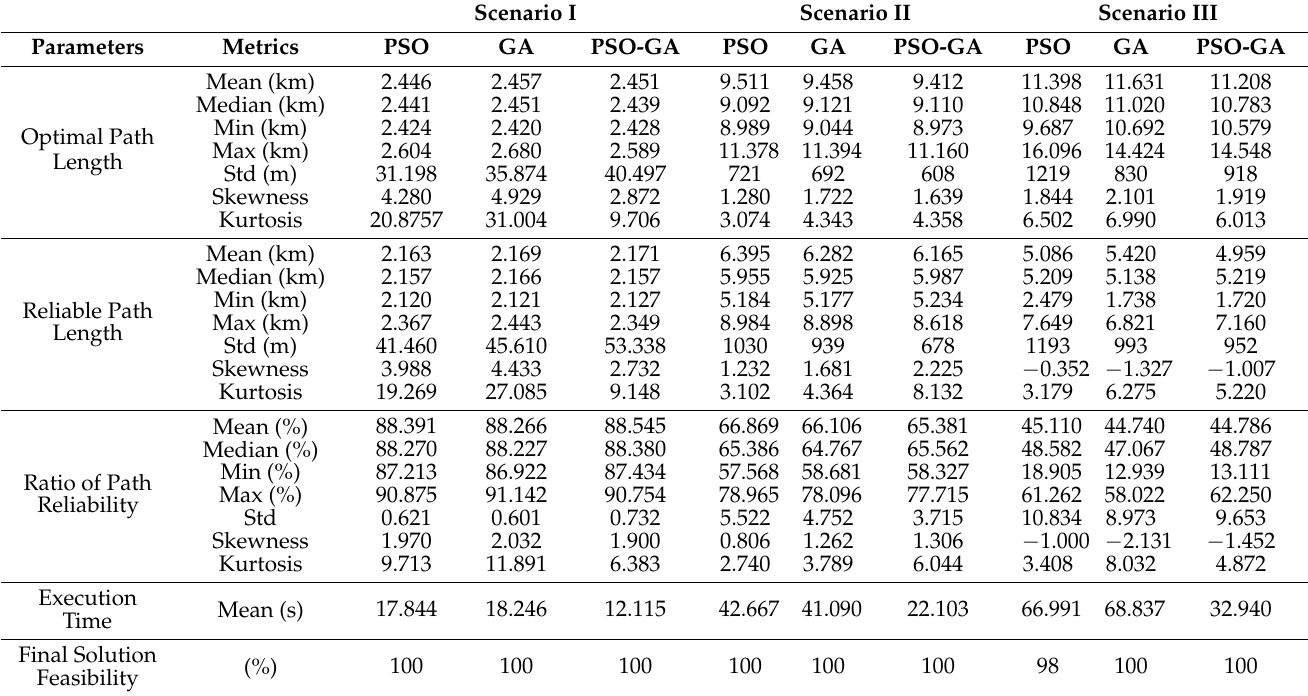
Table A1. Statistical results of the simulations under different